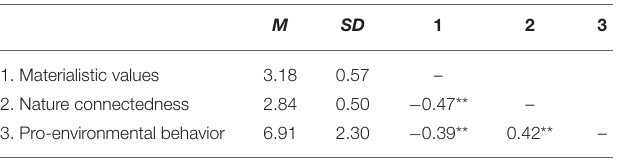
TABLE 2 | Descriptive statistics and intercorrelations between variables in Study